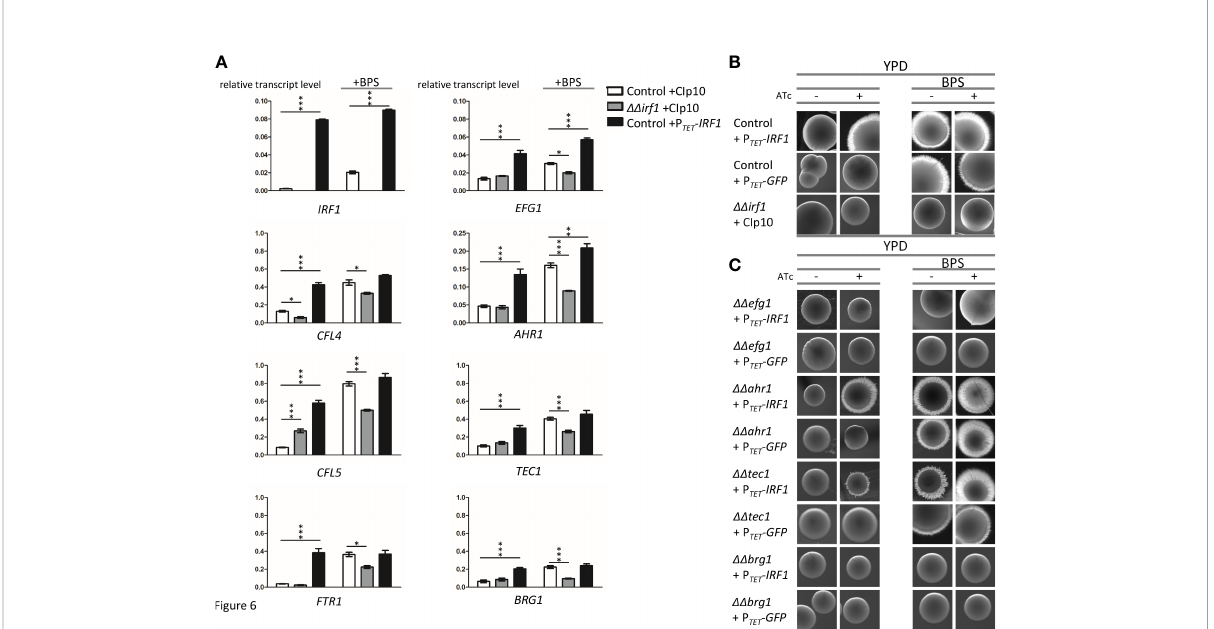
FIGURE 6 Irf1 is dispensable for the regulation of genes involved in iron uptake but critical for iron de fi ciency-induced fi lamentation. (A) qRT-PCR was used to investigate the in fl uence of Irf1 on the expression of genes that play a role in iron uptake ( CFL4 , CFL5 , FTR1 , left side) or that are important for fi lamentation ( EFG1 , AHR1 , TEC1 and BRG1 , right side). A control strain harbouring either the empty plasmid CIp10 (white bars) or the overexpression plasmid P TET - IRF1 (black bars) and the irf1 mutant strain harbouring the CIp10 plasmid (grey bars) were grown to logarithmic phase in YPD medium or YPD medium supplemented with BPS (150 m M) and used for RNA extraction and subsequent cDNA synthesis. Data are expressed as average with SEM. Asterisks indicate signi fi cant differences in gene expression levels compared to those of the control strain determined by a two-tailed Student ’ s t -test. (*) P < 0.05; (**) P < 0.01; (***) P < 0.001. (B) A low concentration of BPS (150 m M) was used to activate fi lamentation induced by iron starvation of C. albicans control strain harbouring the pNIM1 derived P TET - IRF1 overexpression plasmid and the irf1 mutant strain harbouring the empty control plasmid grown on the surface of YPD plates either supplemented with anhydrotetracycline (+ATc) or without. Macrophotographs of single colonies were taken after 4-5 days of incubation of the plates at 30°C.